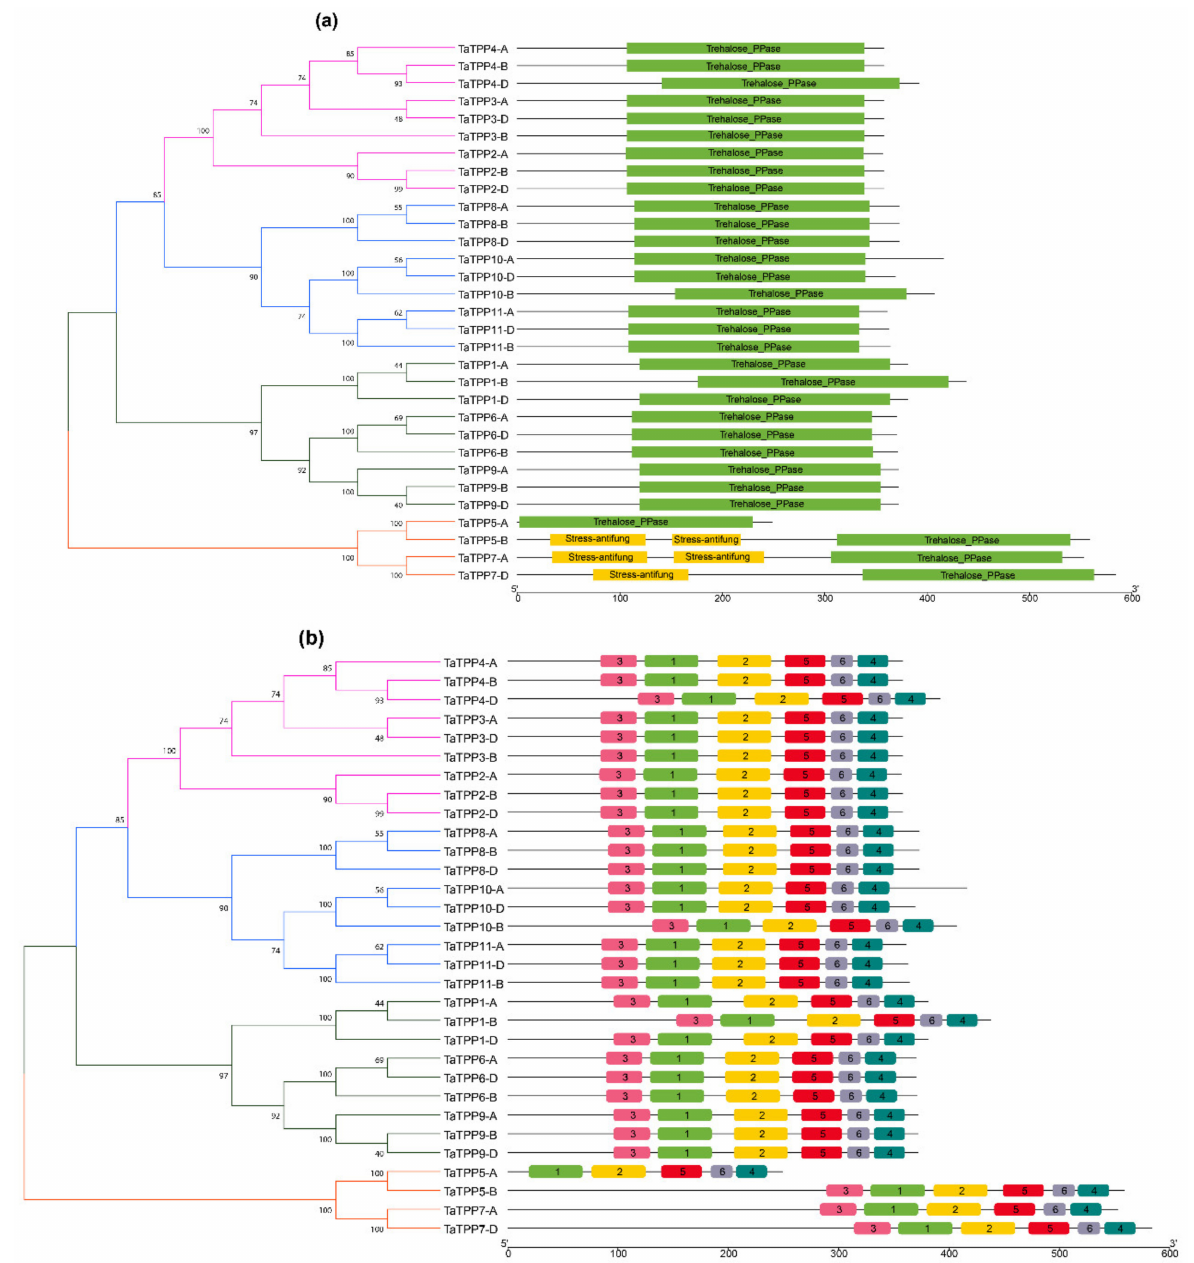
Figure 4. Conserved domain and motif of TaTPPs. ( a ) The conserved domain of TaTPP members was identified from Pfam and SMART databases and presented using TBtools. ( b ) The conserved motifs of TaTPP members. Six motifs were identified using MEME program and presented with different colored